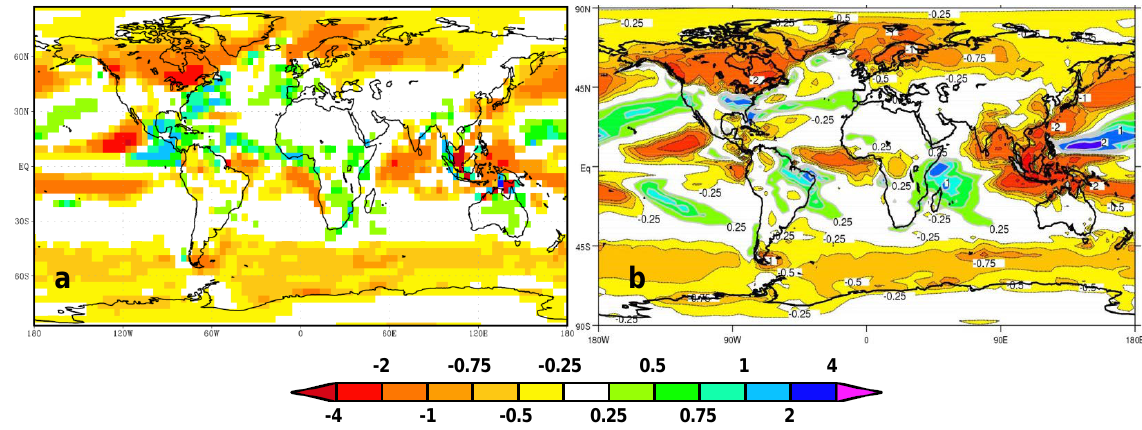
Fig. 3. Same as Fig. 2, except for differences in annual mean precipitation (in mmd − 1 ).